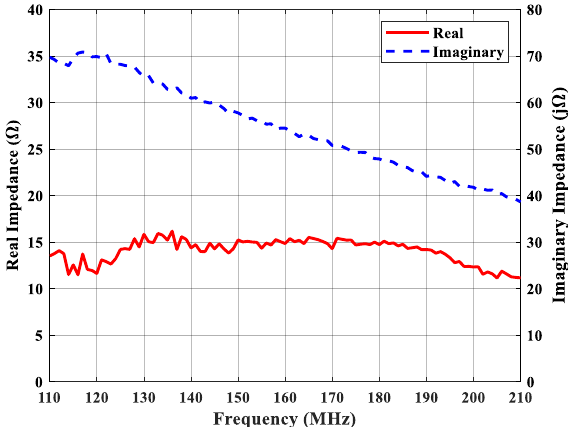
Figure 17. The measured impedance of the non-Foster circuit.